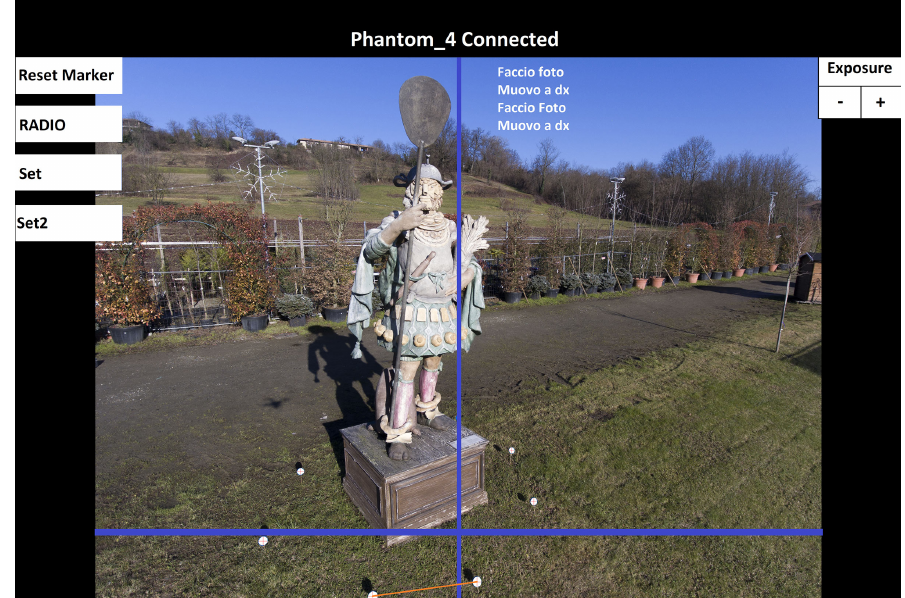
Figure 7. A screenshot of the dashboard of our application, during an acquisition